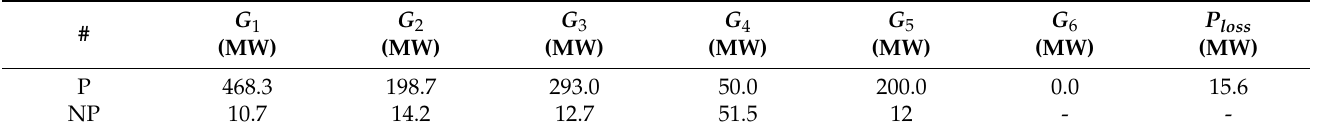
Table 4. Result of Quota Analysis of Genco Losses and Nodal Price.